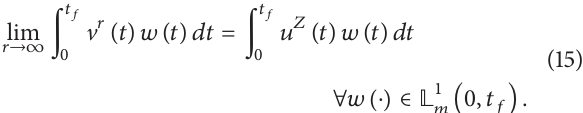
Figure 1: Approximation of an element 𝛽 𝑍 [𝑡 𝜌 𝑍 (⋅) by Fourier